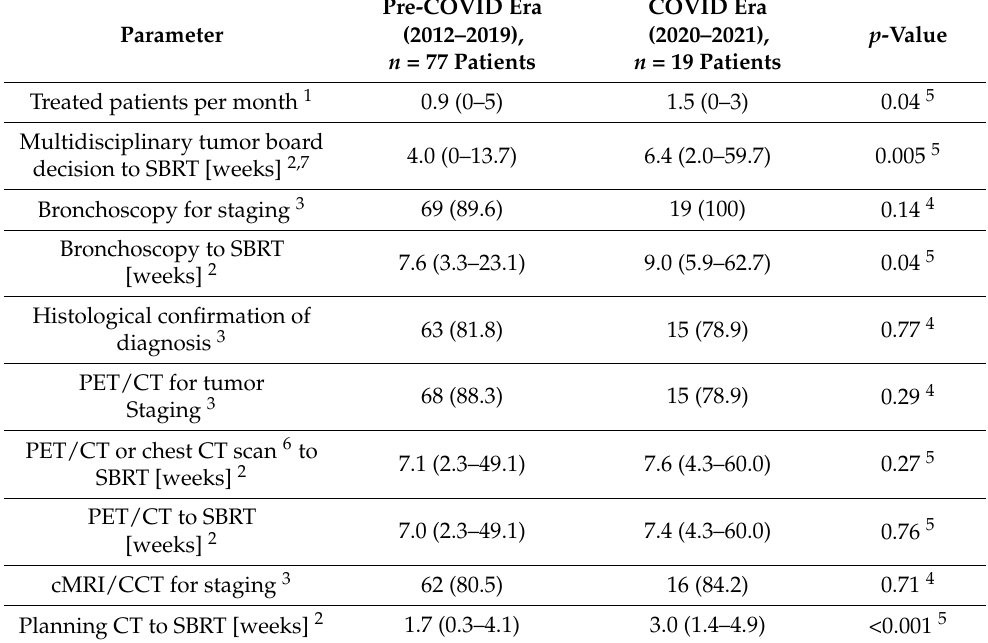
Table 2. Comparison of pretreatment assessment between patients treated in the pre-COVID (Coron- avirus Disease) era (here defined from 2012–2019) and in the COVID era. The times for the parameters were calculated to the first day of SBRT (stereotactic body radiation therapy). PET/CT: positron emission tomography/computed tomography. CT: computed tomography. cMRI: cranial magnetic resonance imaging. CCT: cranial computed tomography. 1 Mean (min-max). 2 Median